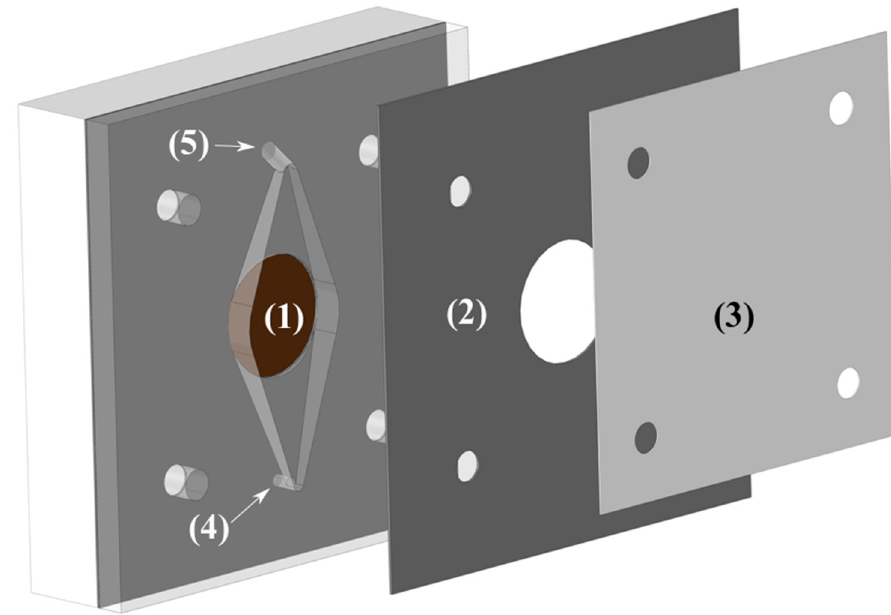
Figure 3. Schematic representation of one half of the cell. (1) Electrode housing. (2) Structural divider. (3) Membrane. (4) Electrolyte inlet port. (5) Electrolyte outlet port.